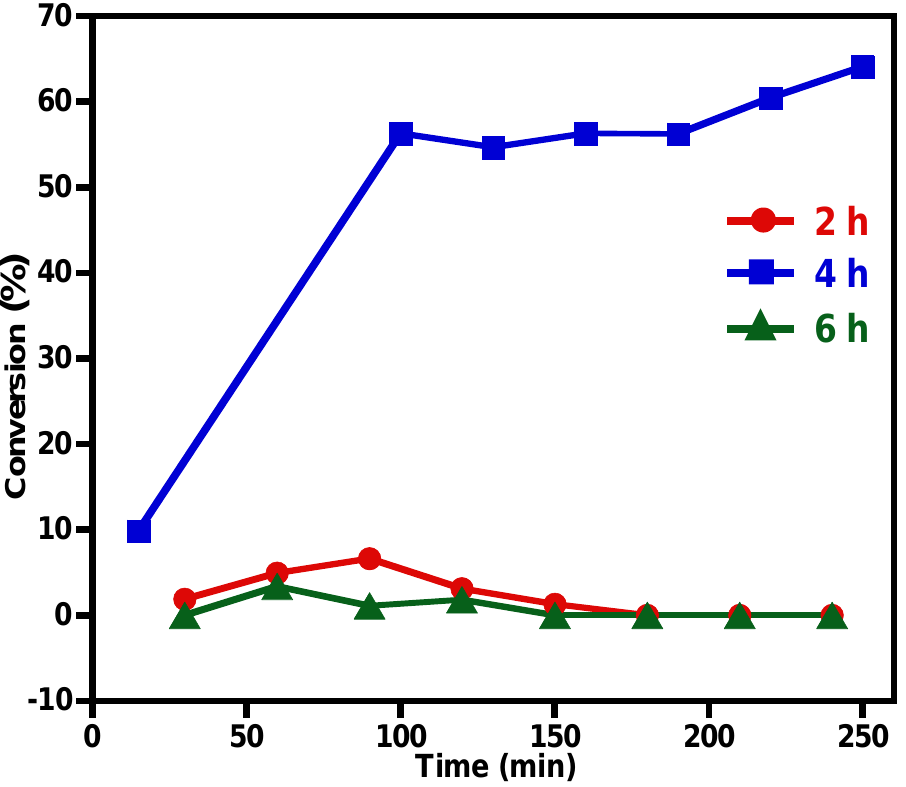
Figure 7. Effect of aging time in the conversion of oxidation of toluene under molecular oxygen using Cu x Zn y O mixed metal oxide nanoparticles calcined at 450 °C (conditions: catalyst amount: 0.3 g; toluene flow: 0.01 mL/min; calcination temperature: 450 °C; reaction temperature: 250 °C).